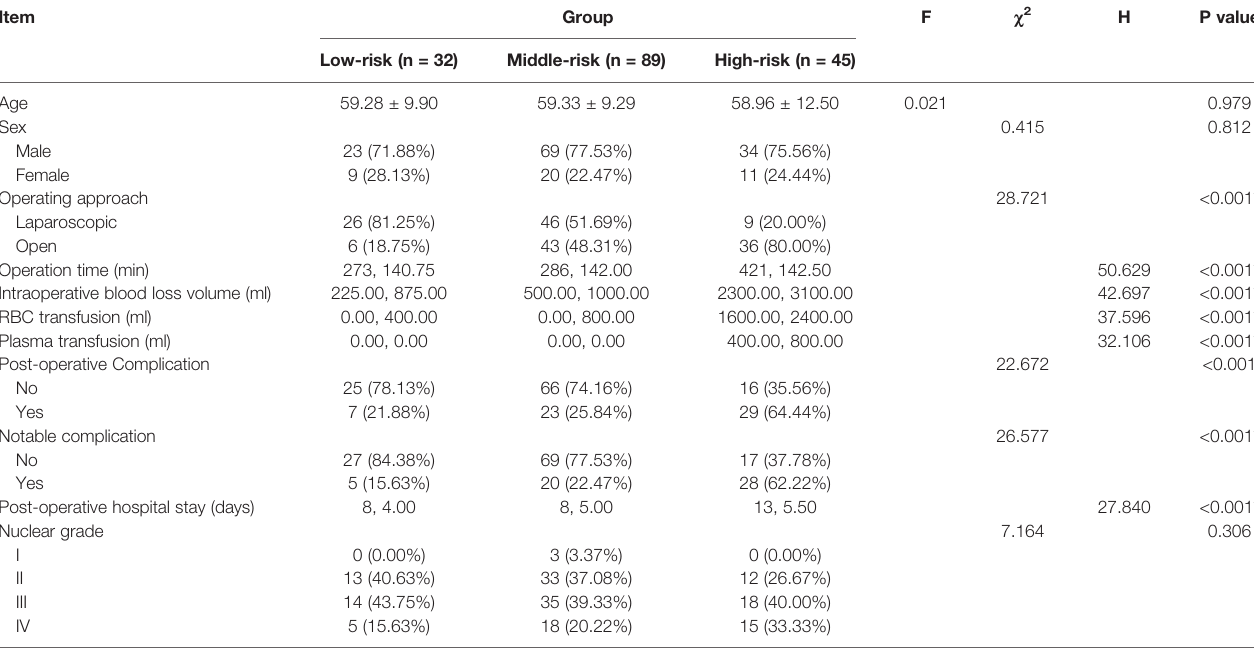
Normally distributed data are presented as the mean ± SD; data of other distribution patterns are shown as (median, IQR). RBC, red blood cell. F, statistic in one-way analysis of variance (ANOVA). c 2 , statistic in Chi-square test. H, statistic in Kruskal − Wallis H test. *, signi fi cant difference detected both in trial group and validation group; SD, standard deviation; IQR, interquartile